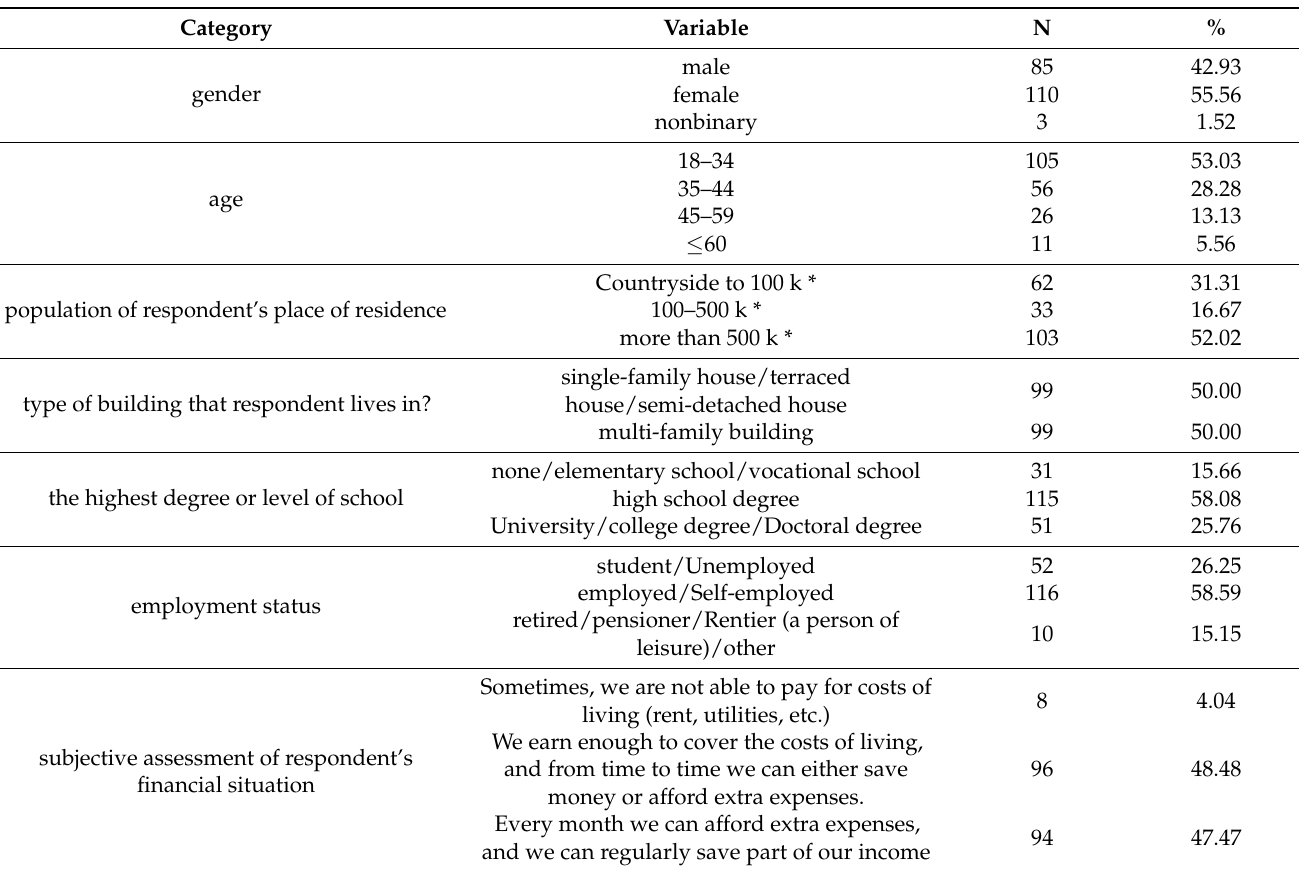
Table 2. Selected socio-economic characteristics of the sample N (N =